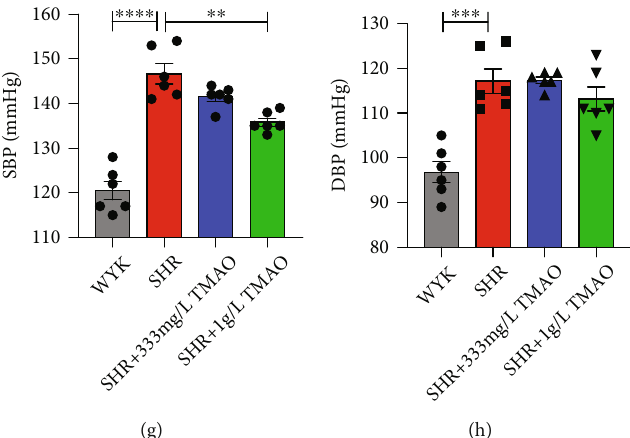
Figure 2: E ff ect of gut microbial-related choline metabolite TMAO on the development of hypertension. After 22 weeks treatment with water or TMAO, variation in the plasma (a) TMAO concentration, (b) TMA, (c) 24 hours water intake, (d) food intake, (e) body weight, (f) 24-hour urine output, and (g) systolic and (h) diastolic blood pressure of rats in each group. Results are mean ± SD . ∗ p < 0 : 05 ; ∗∗ p < 0 : 01 ; ∗∗∗ p < 0 : 0005 ; ∗∗∗∗ p < 0 : 0001 . Grey bars represent Wistar-Kyoto (WKY) rats ( n = 6 ); red bars represent spontaneously hypertensive rats (SHRs) treated with water ( n = 6 ); blue bars and green bars represent SHRs treated with water containing 333 mg/L ( n = 6 ) and 1g/L TMAO ( n = 6 ),